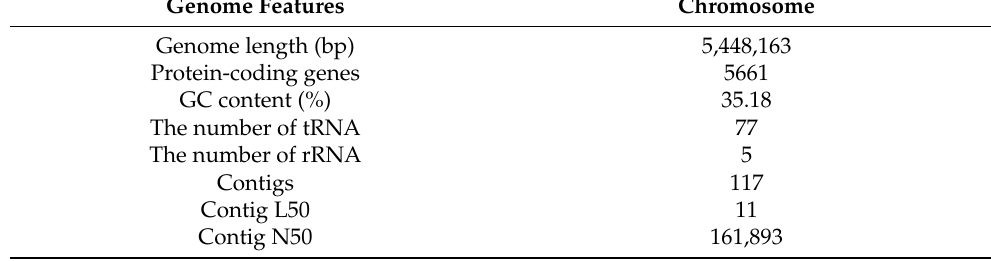
Table 2. Genomic features and annotation information of the chromosome of Bacillus sp. B87.